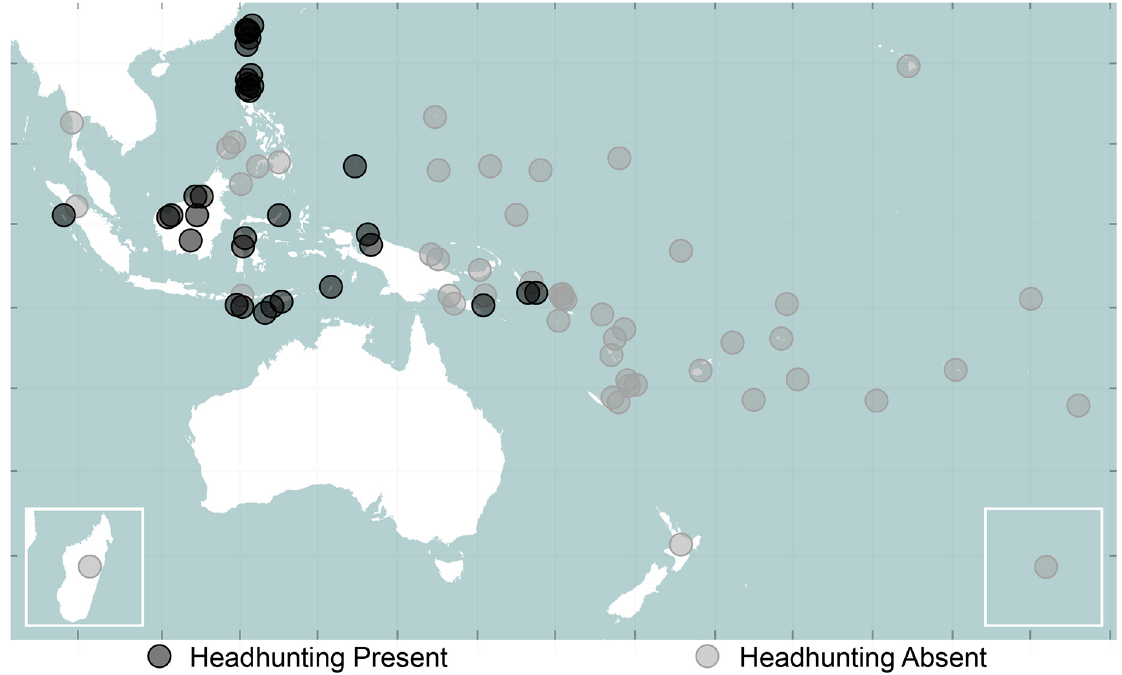
Fig 3. Geographic distribution of headhunting in Austronesia. Madagascar is in the lower left box and Rapa Nui is in the lower right box. The axes represent the latitude and longitude of cultures in decimal degrees. Figure made using vector map data from Natural Earth.